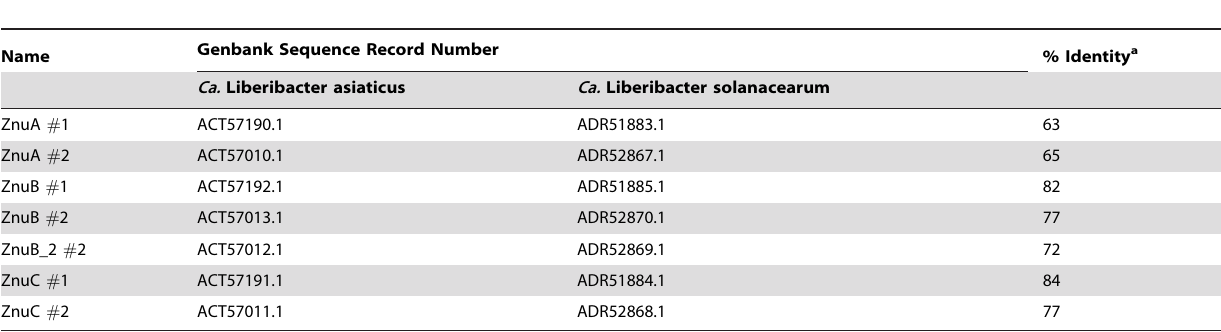
a Percentages are based upon a ClustalW alignment between the corresponding proteins.